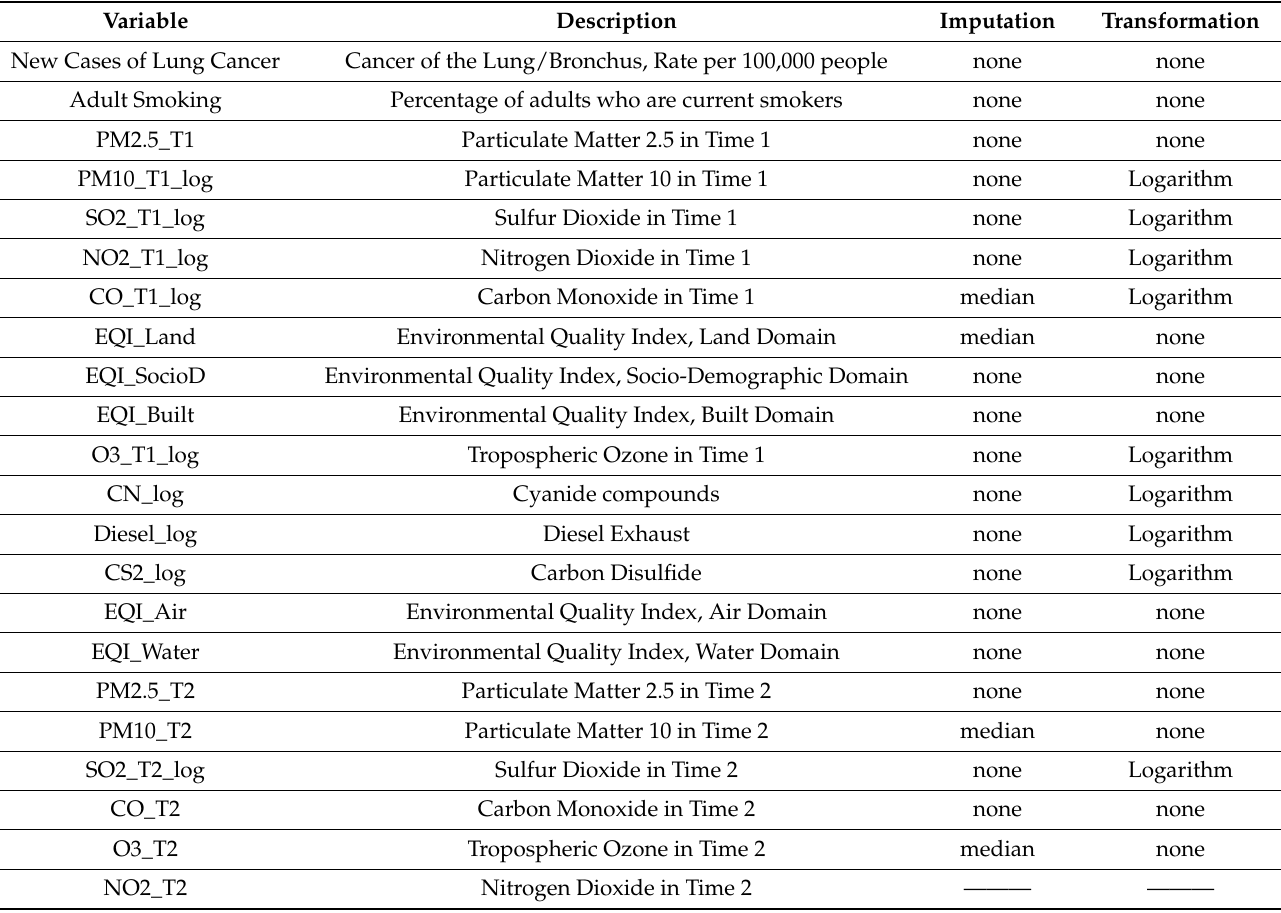
Table 3. Variables and Data Cleaning.